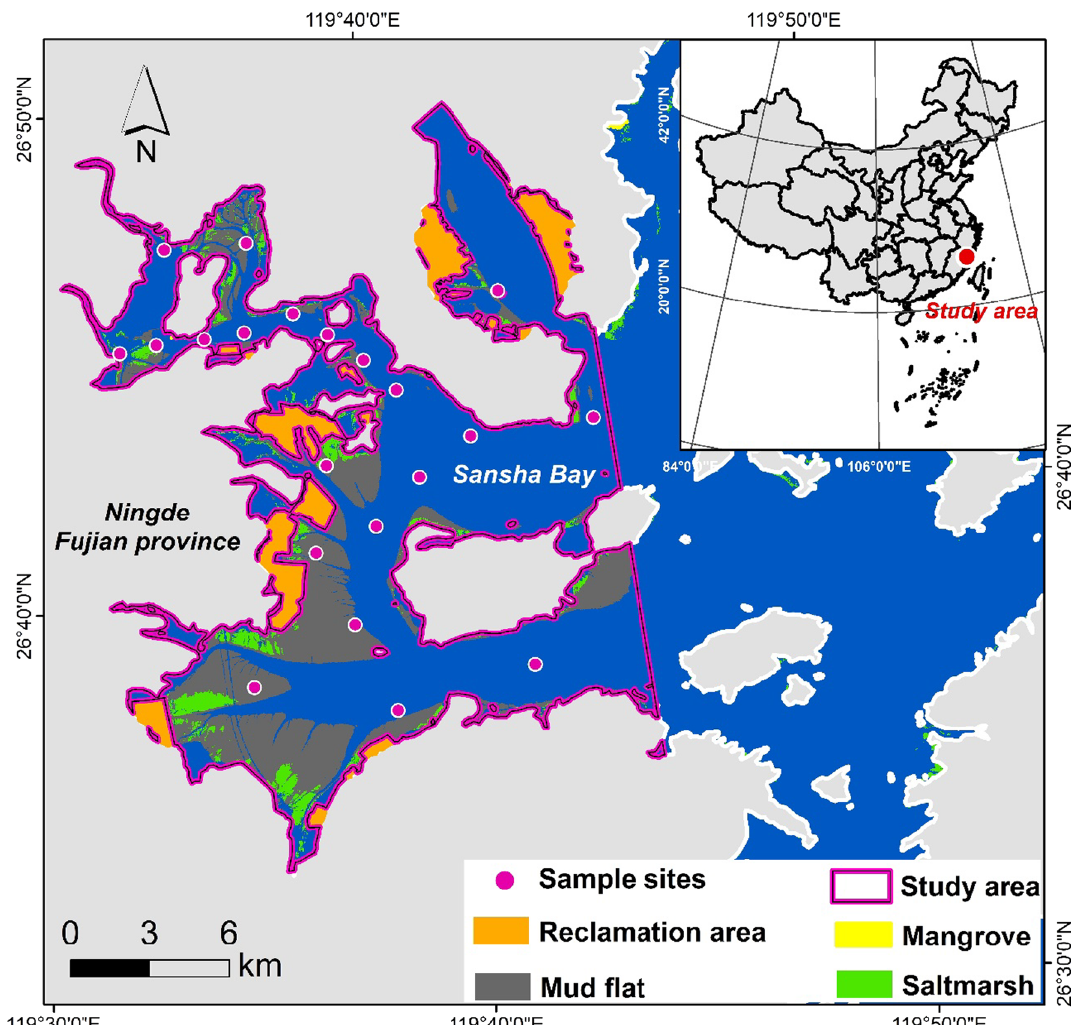
Fig. 1 Location of Sansha Bay and distribution of coastal habitats, reclamation areas, and sampling